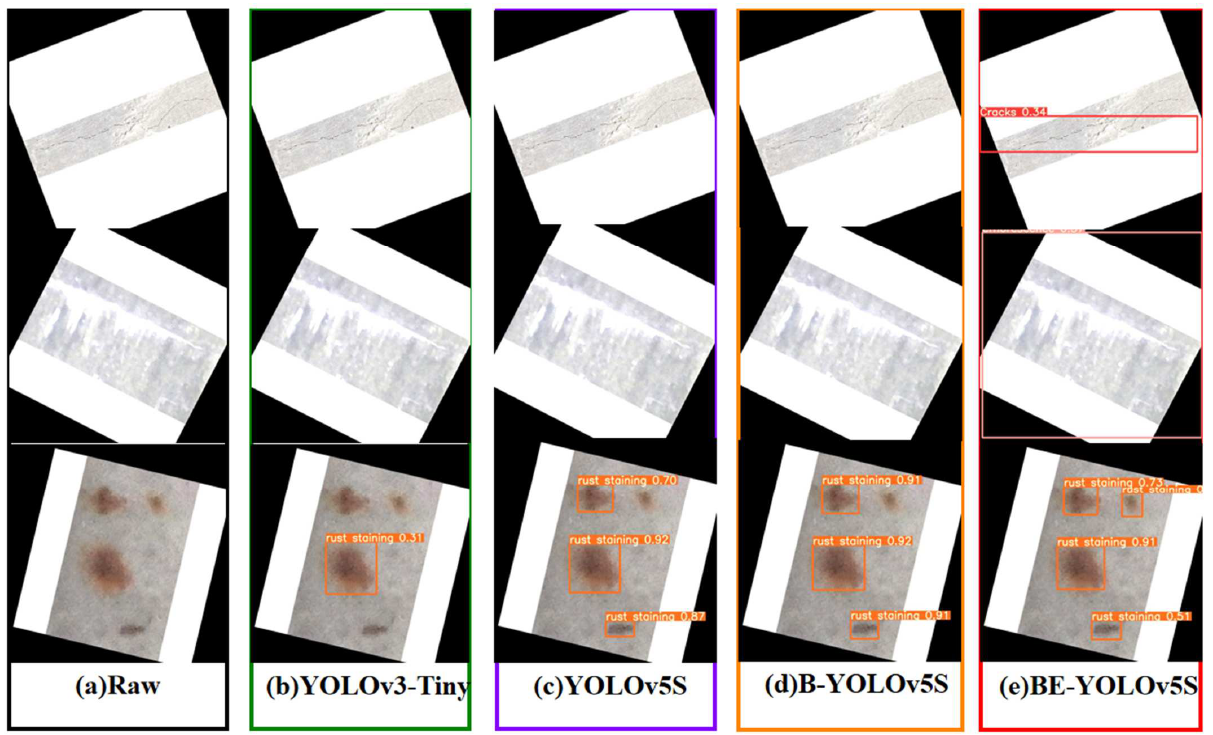
Figure 9. Comparison chart of detection performance of four types of bridge damage models under complex conditions. ( a ) Undetected original image; ( b ) Performance rendering of YOLO-V3-Tiny model detection; ( c ) rendering of YOLOv5S model detection performance; ( d ) rendering of B-YOLOv5S model detection performance; ( e ) BE-YOLOv5S model detection performance renderings (the images used are all bridge damage images from the BDD-E dataset).